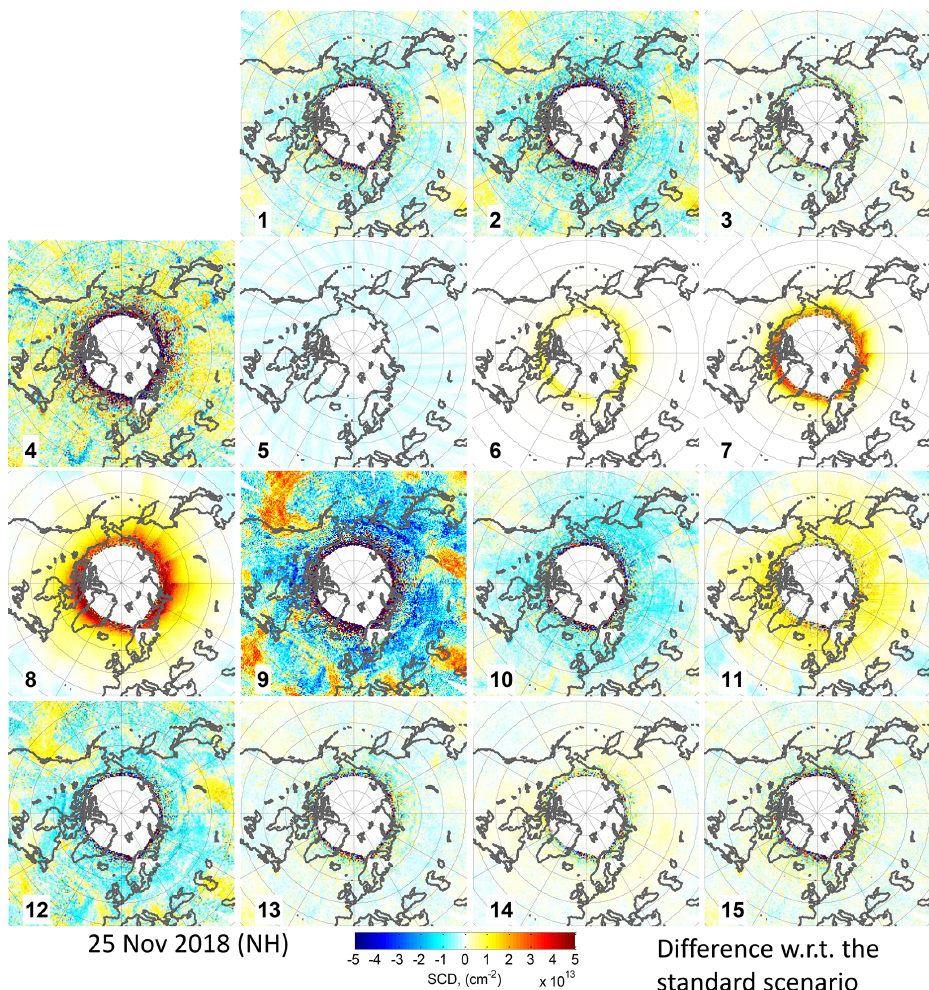
Figure B5. Differences between the OClO SCDs shown in Fig. B4 and those of the standard